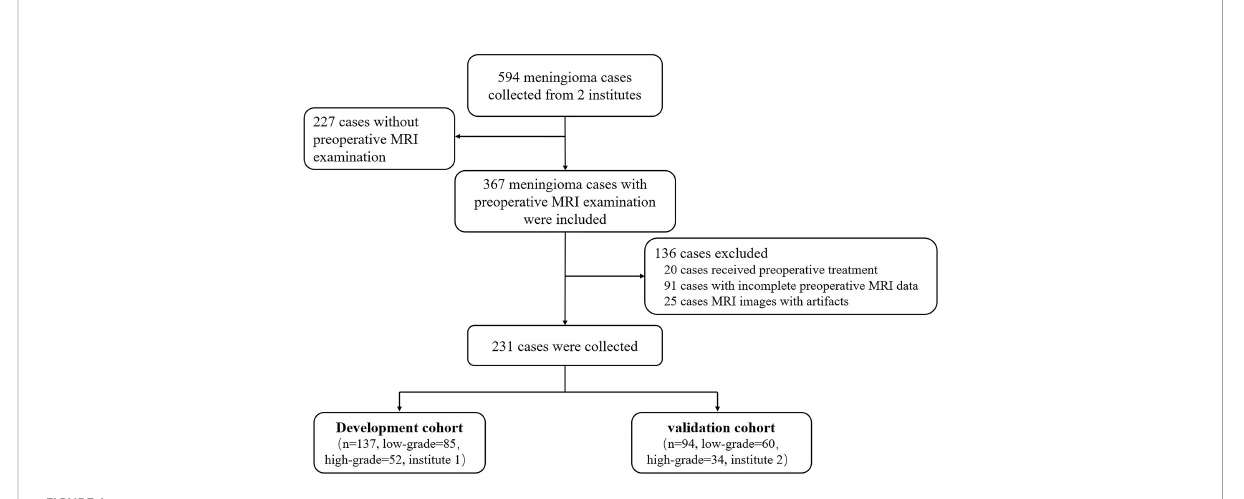
FIGURE 1 How the study population was collected.